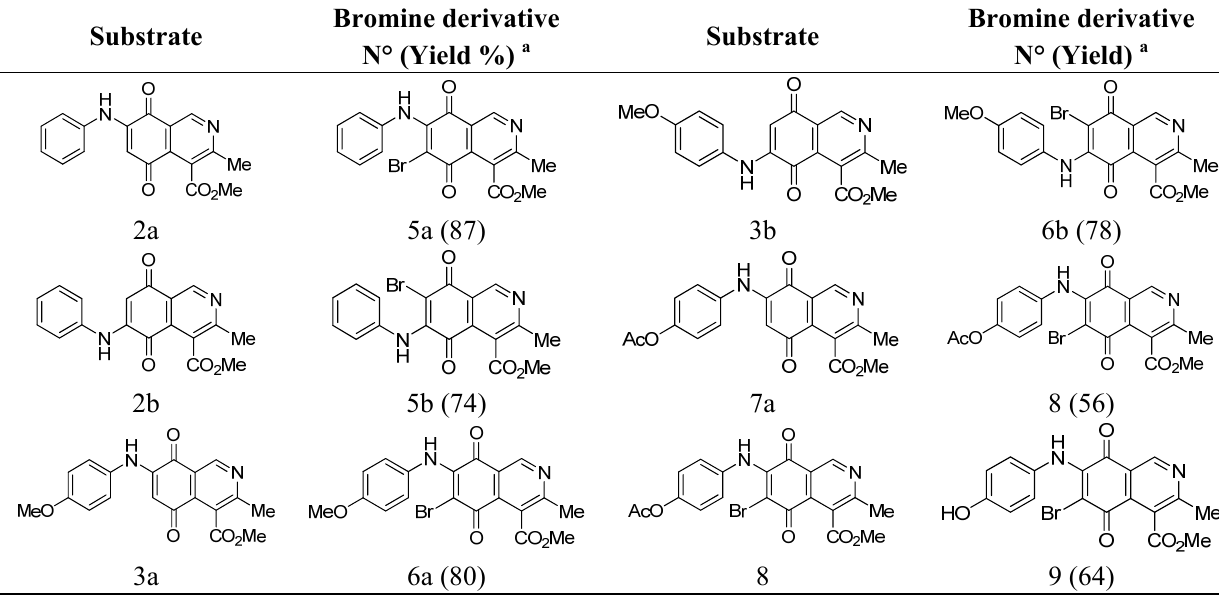
Table 1. Preparation of phenylaminobromine derivatives 5a , b , 6a , b , 8 and 9 .